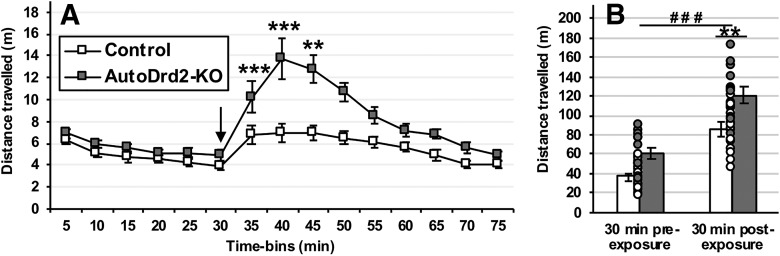

Locomotor response to cocaine. While both groups expressed cocaine-increased locomotion after cocaine injection (arrow), autoDrd2-KO mice showed an exaggerated response compared to littermate controls, as shown by significant differences between genotypes appearing during the 35-, 40-, and 45-min time bins (**p = 0.01, ***p < 0.001; A). When comparing locomotion during the 30-min pre- vs postexposure to cocaine, there was an overall significant effect of the drug (###p < 0.001), as well as a significant difference between genotypes during the postexposure period (**p < 0.01; B). Each dot represents a single data point. Bars show group means ± SEM.